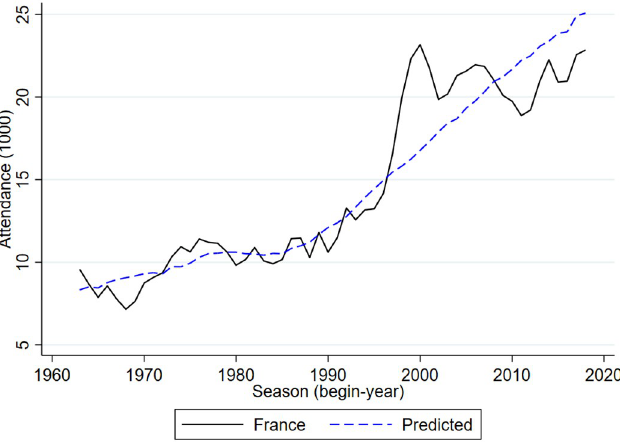
Fig 9. Stadium attendance professional football; actual and predicted attendance France; 1963/64-2018/19 (1000).